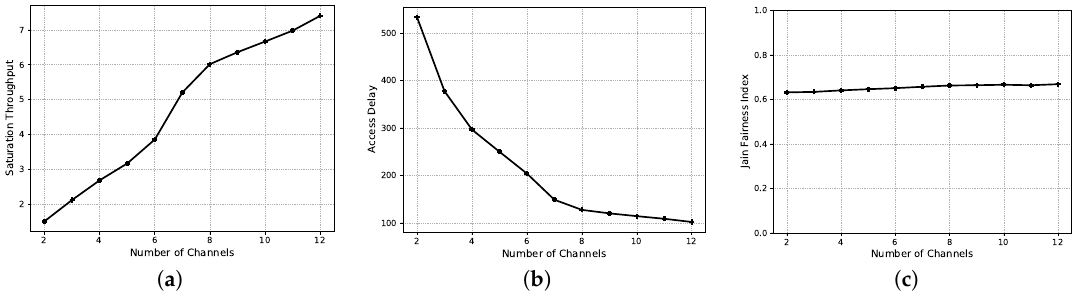
Figure 7. Performance of SA-MMAC for 100 nodes. ( a ) Saturation throughput; ( b ) access delay; ( c ) frame drop ratio.